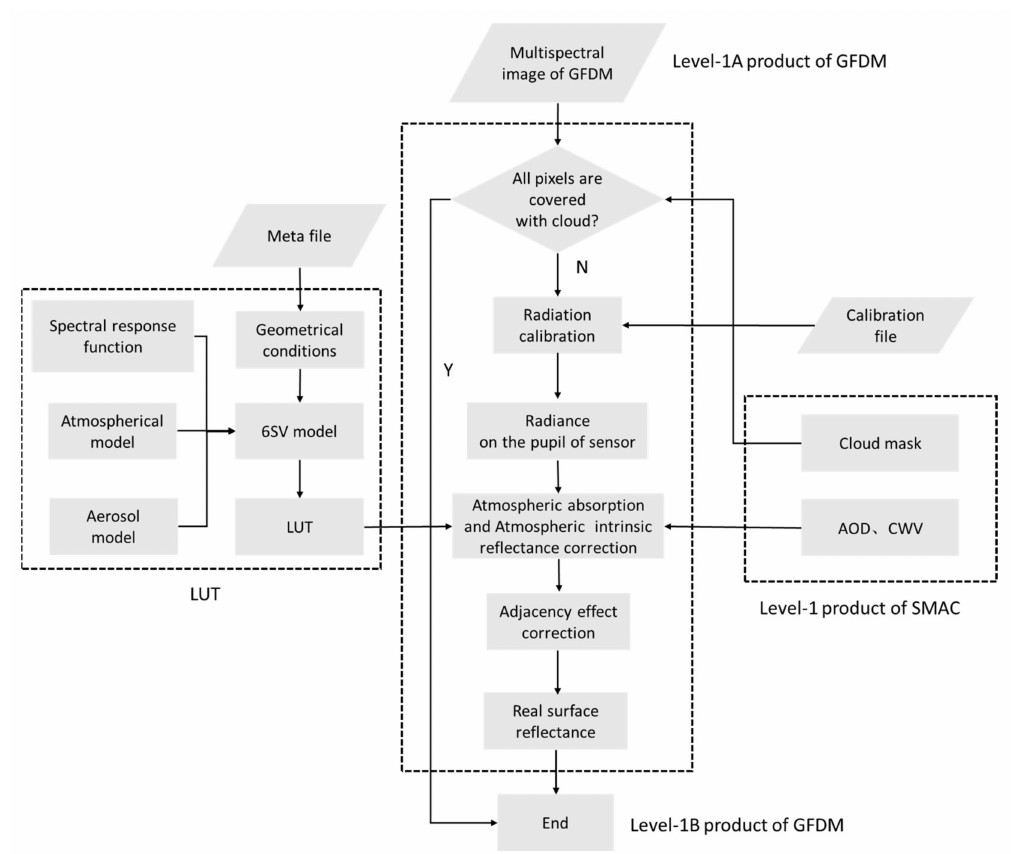
Figure 5. Procedures for synchronization atmospheric